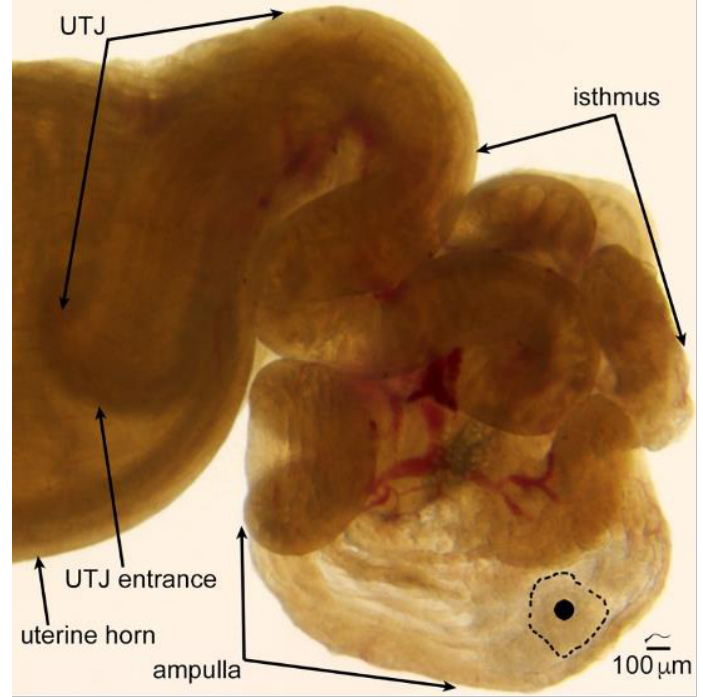
Figure 3. A transilluminated mouse oviduct. The ovary has been removed, but the coiling of the oviduct has been left in place. The size of mouse sperm (about 125 μm) is illustrated above the scale bar. To appreciate the size of the oocytes and cumulus in the ampulla, one of the oocytes has been covered by a solid black circle and the border of its cumulus indicated by a dotted line. Note that longitudinal folds line the uterotubal junction (UTJ) and the ampulla, while transversely oriented folds that form pockets can be seen in the isthmus, the site of sperm storage. Only the tip of a uterine horn is shown. Used with permission from Ref. [38]. Copyright 2010 Oxford University Press.